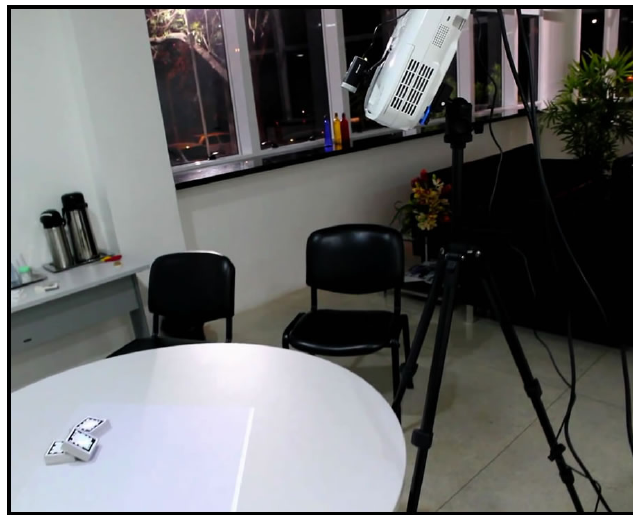
Camera-projector system setup, using a tripod. The projector illuminates the table where the children can use the system. The calibration step was executed in an average time of 4.701 seconds. It’s an off-line phase performed automatically during the system initialization. Even though it is not an online step, it is faster than the case in which the users need to adjust these parameters